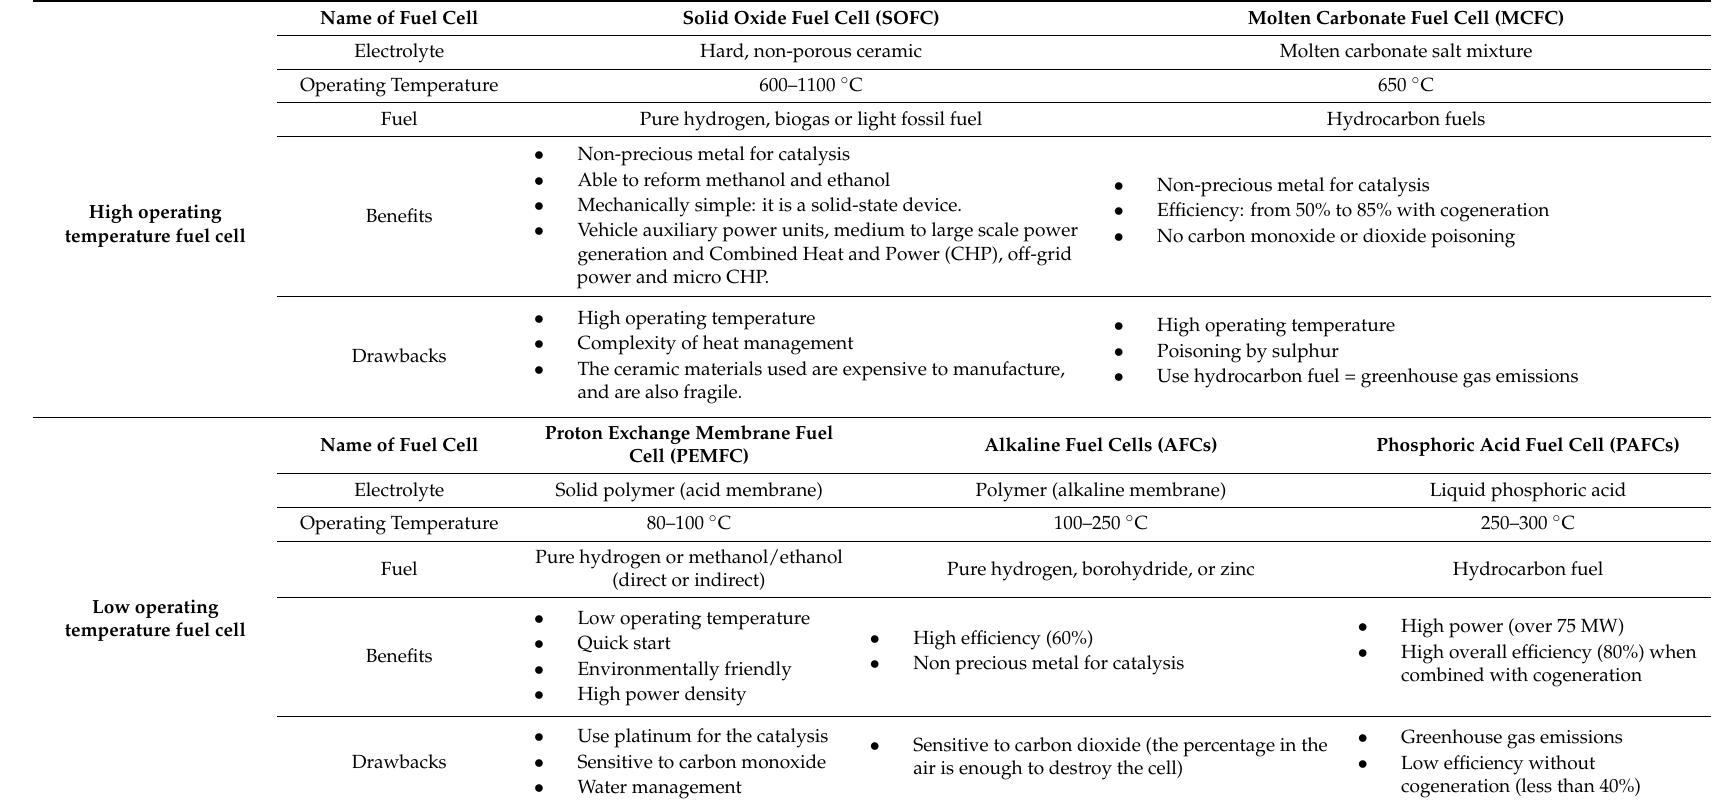
Table 1. Fuel cell type classification